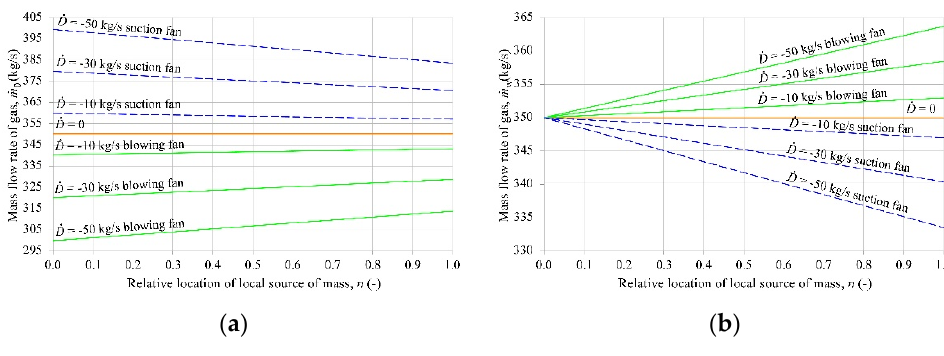
Figure 5. Results of numerical calculations for ( a ) Case 2a, ( b ) Case 2b.